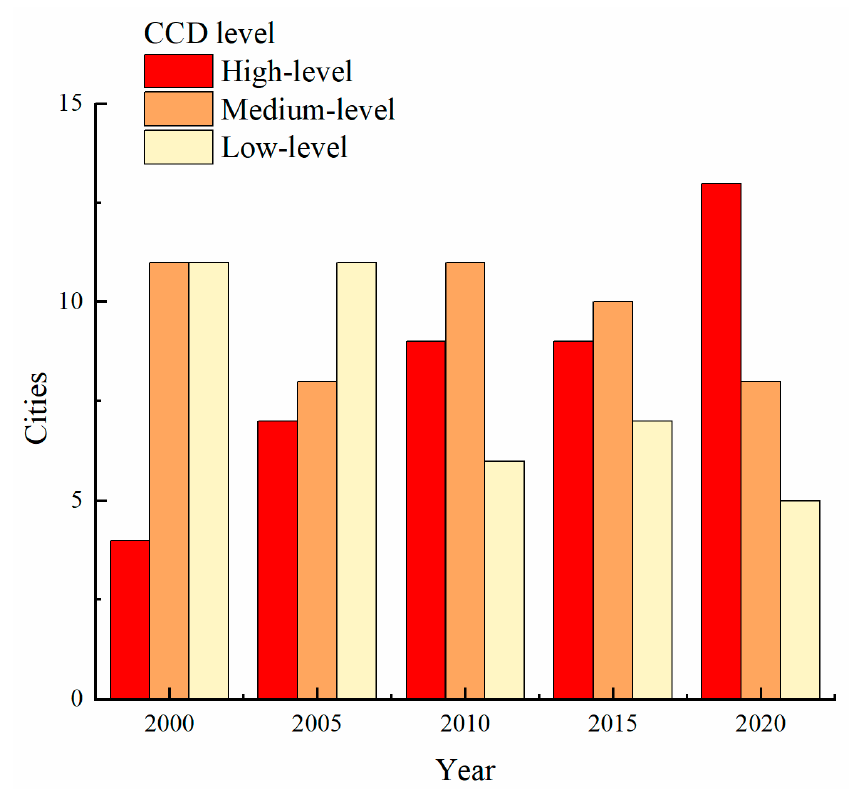
Figure 8. The quantity change of graded CCD in the YRDUA.